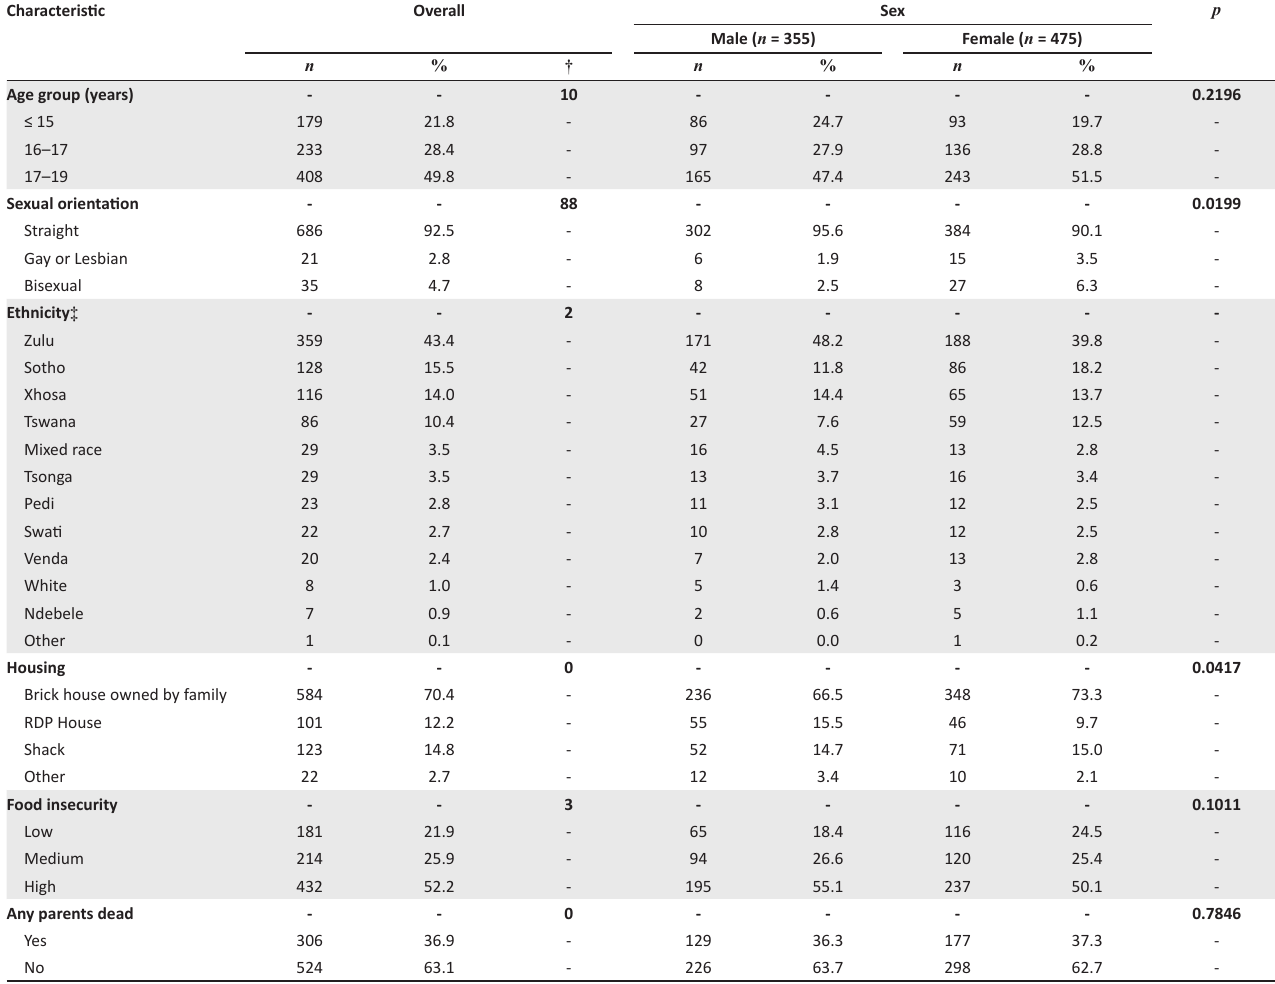
TABLE 1: Socio-demographic characteristics of male and female adolescents (ages 14–19 years) in the Botsha Bophelo Adolescent Health Study ( N = 830).